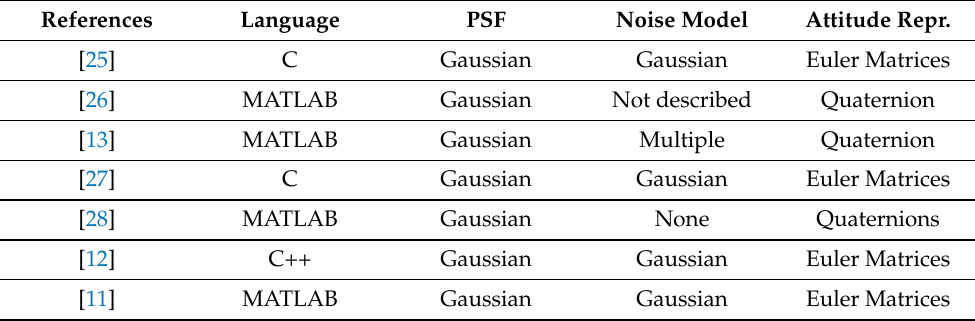
Table 1. Instances of star simulators in